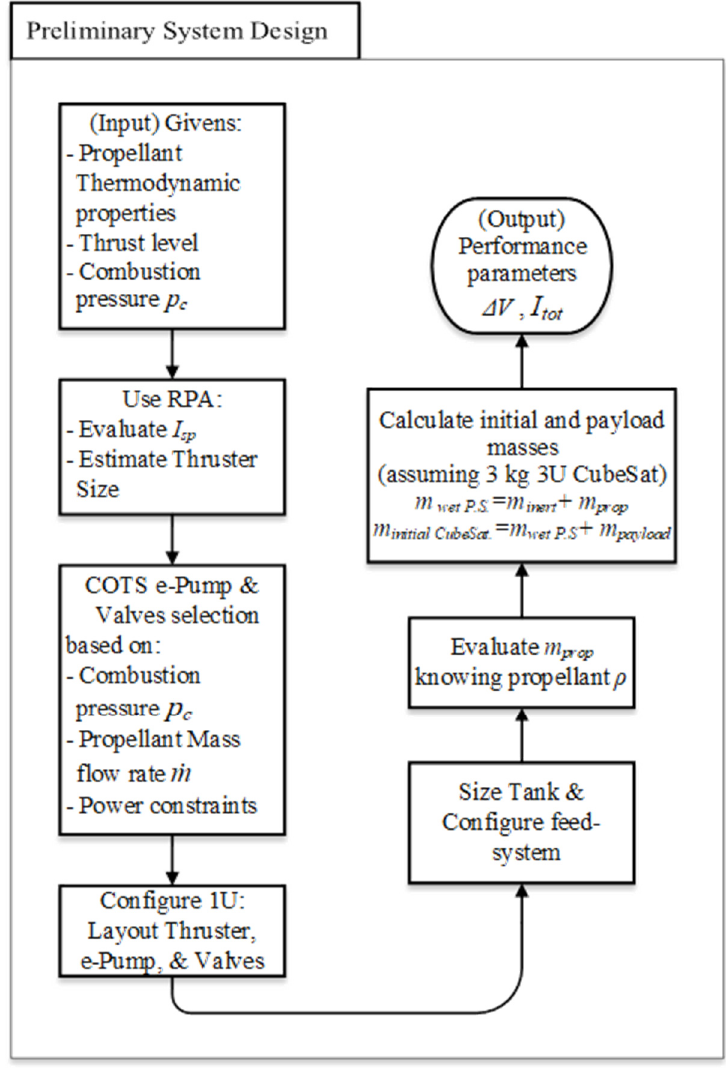
Figure 5. Preliminary design flow chart.